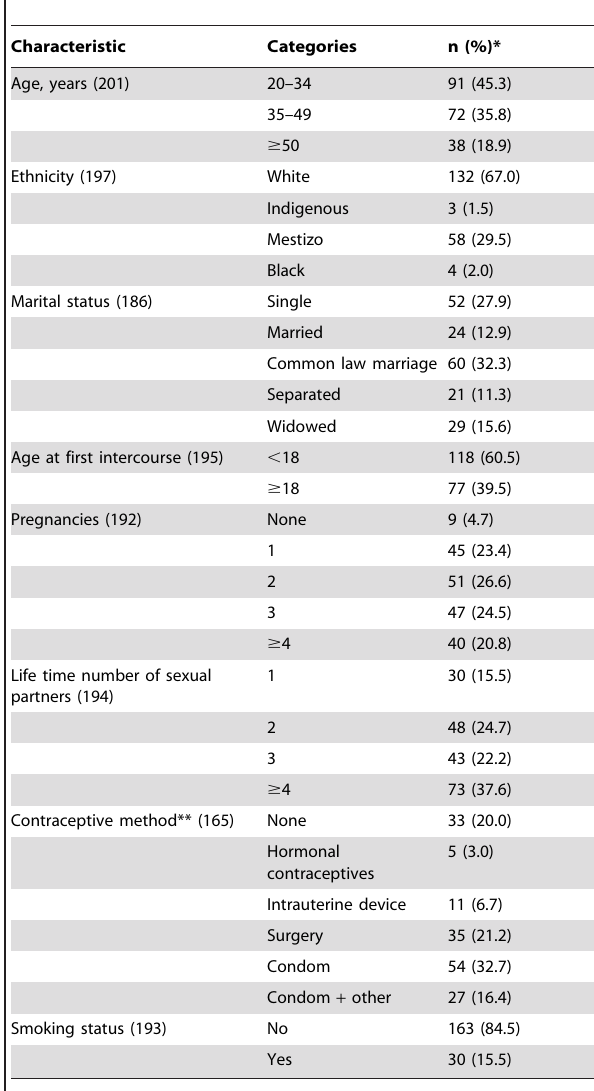
Table 1. Description of the socio-demographic characteristics of the female population enrolled in the